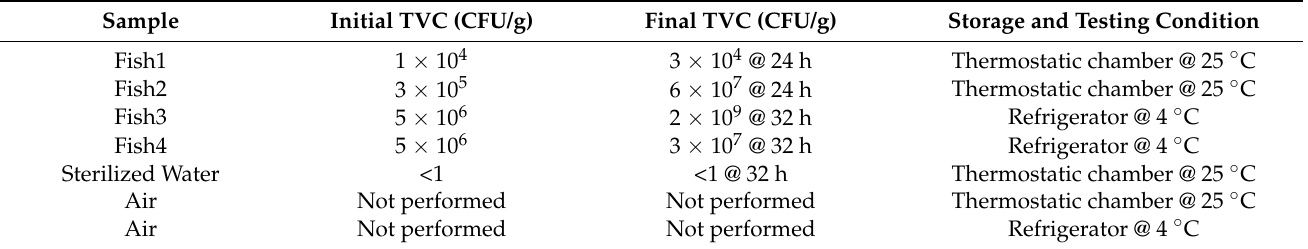
Table 1. Tested samples and main parameters of status, namely, the storage and testing conditions and the initial and final total viable counts (TVC). The TVC values were determined following the procedure described in Section